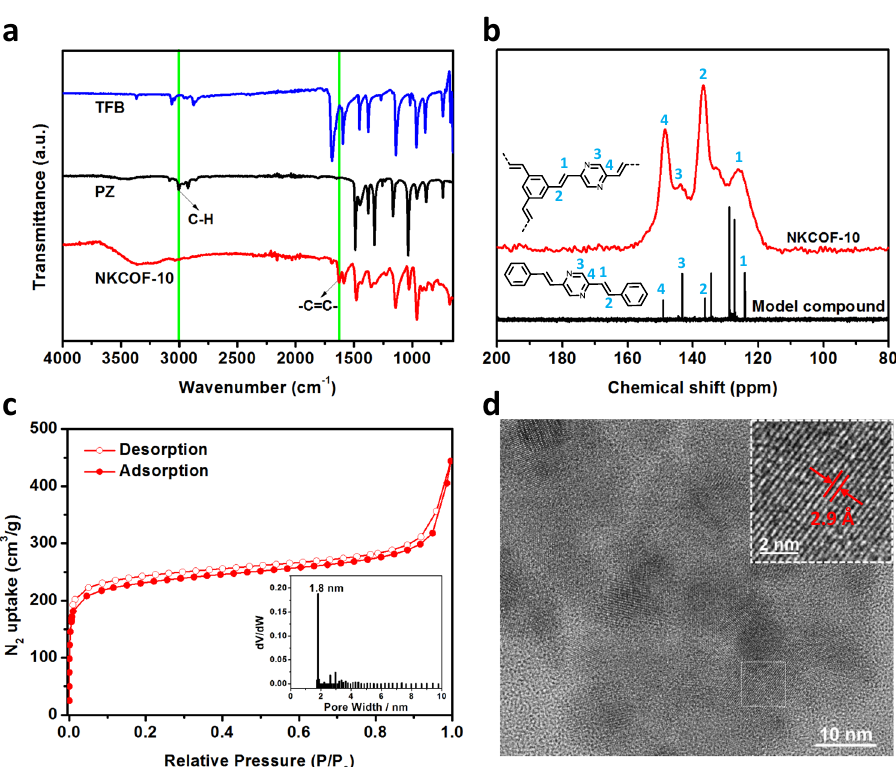
Fig. 3 Physical characterization of NKCOF-10. a FT-IR spectra of NKCOF-10 and corresponding monomers. b 13 C solid-state NMR spectra of NKCOF-10 and liquid 13 C NMR spectra of the model compound. c Nitrogen adsorption and desorption isotherms of NKCOF-10. Inset is the pore-size distribution. d HRTEM image of